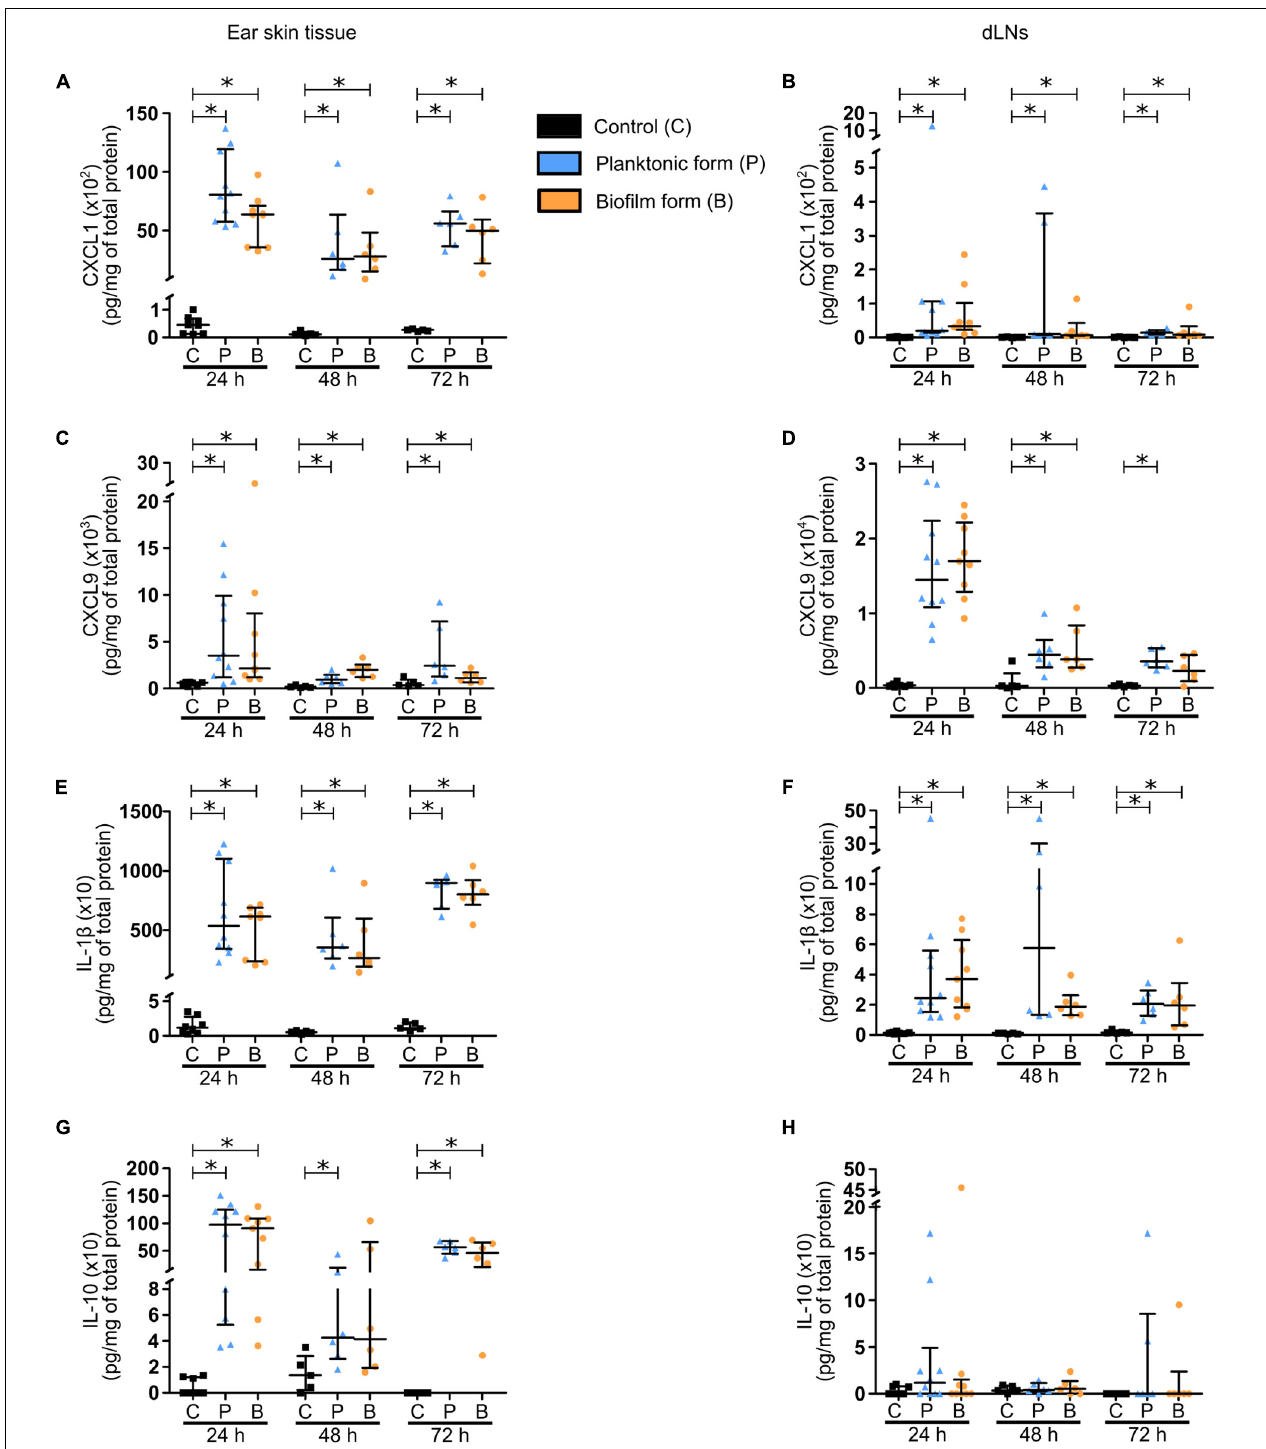
FIGURE 2 | Chemokine and cytokine production in S. aureus infected tissue. (A–H) Chemokine (A–D) and cytokine (E–H) levels, expressed in pg/mg of total protein, analyzed by Bioplex in the supernatants of ear pinna tissues (A,C,E,G) and dLNs (B,D,F,H) homogenates at 24, 48, and 72 h pi (median ± IQR, number of mice: N C = 5–8, N P = 6–10, N BF = 6–9, from at least 3 different experiments, Mann-Whitney two-tailed test, ∗ p <